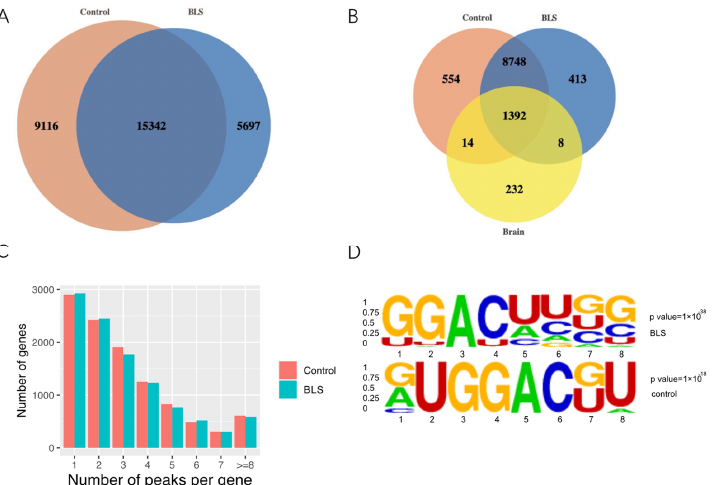
Figure 2. The m6A modification patterns in BLS and control groups. ( A ) The Venn diagram shows the overlap of two groups of m6A genes. ( B ) Venn diagram shows the overlap of m6A peak in the brain of two groups and normal rats. ( C ) The distribution of m6A methylation peaks in each gene. ( D ) The motifs for m6A peak regions based on STREME.